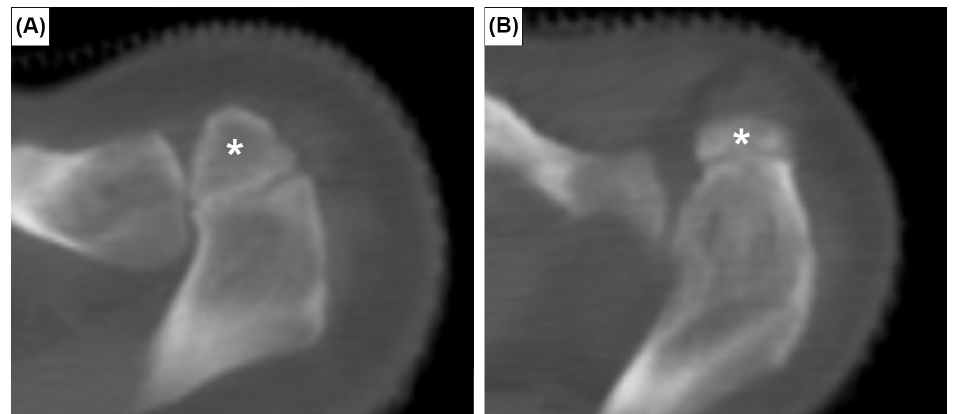
Figure 1. Axial CT images showing two types of os acromiale: meso-acromion ( A ) and pre-acromion ( B ). Asterisks indicate the os acromiale.